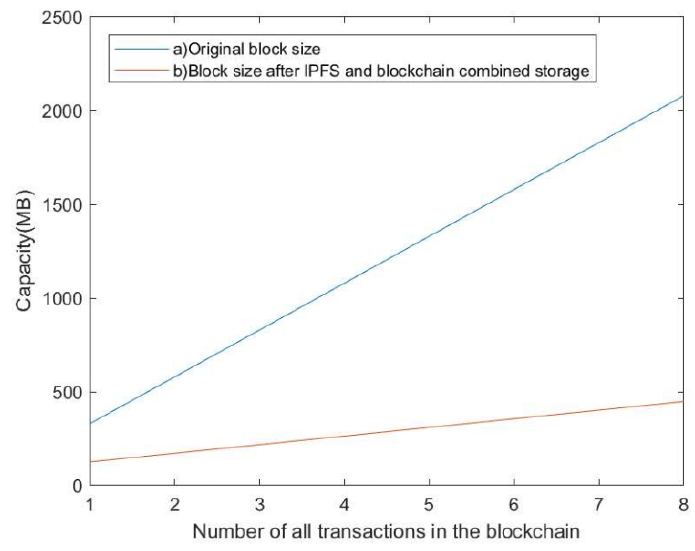
Figure 6. Blockchain capacity